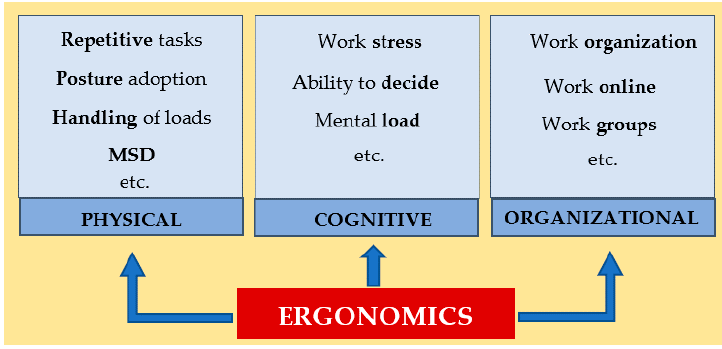
Figure 2. Types of ergonomics (adapted from [6]).